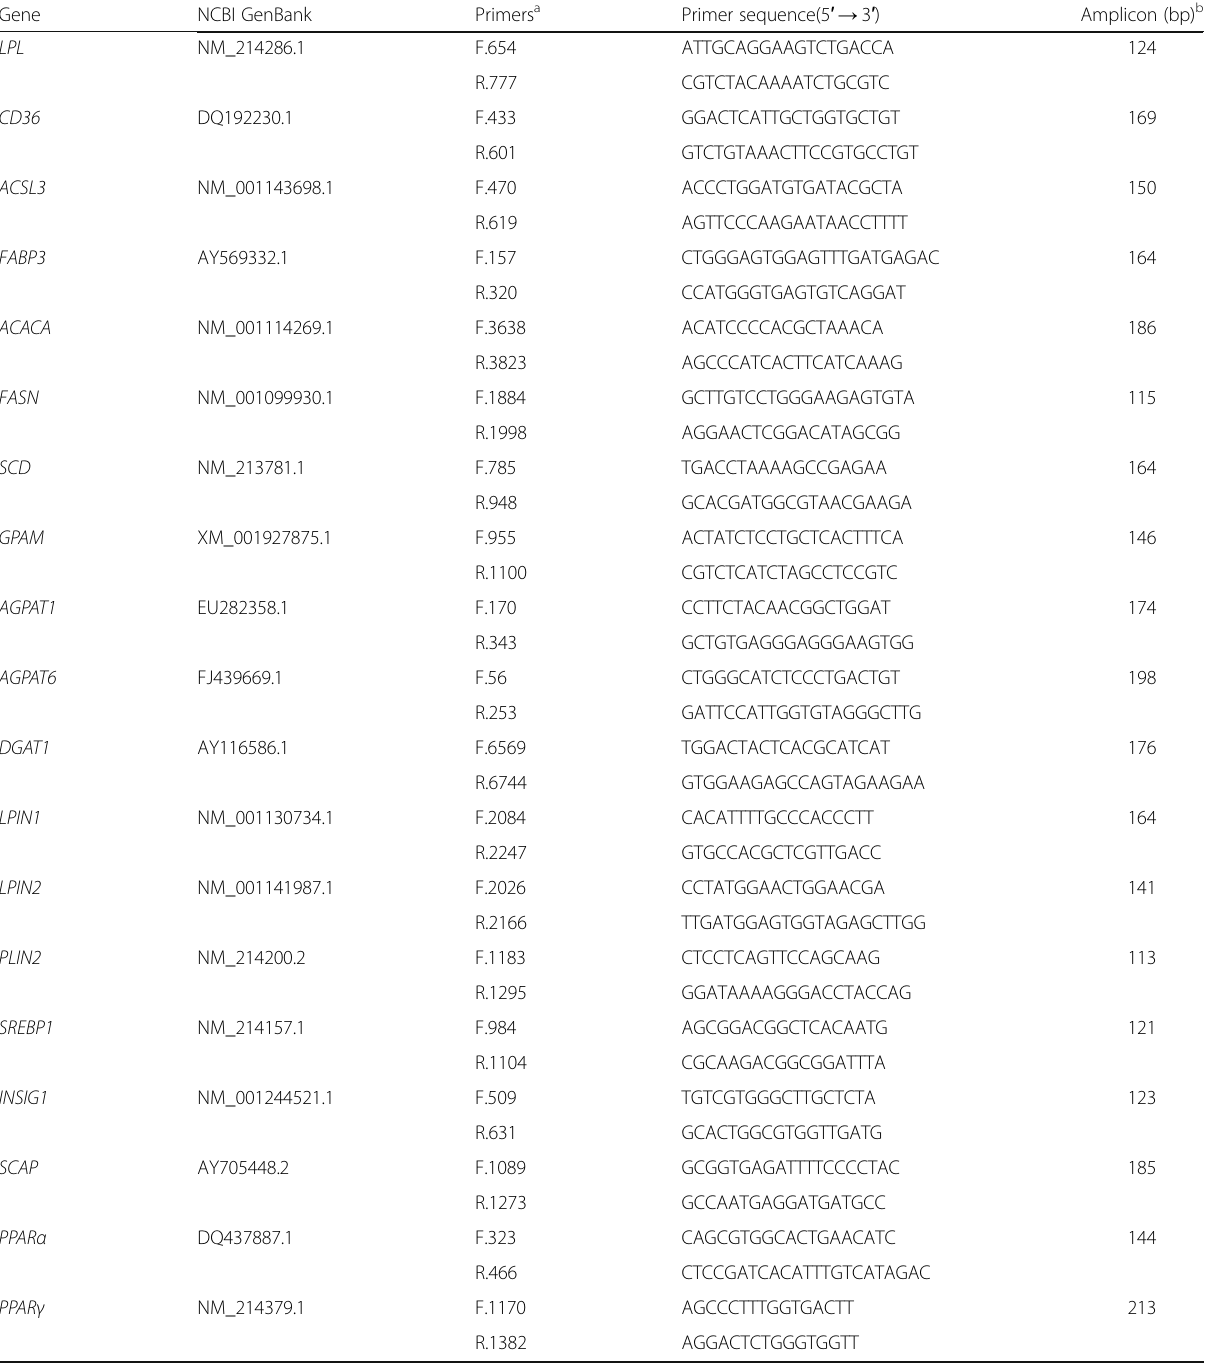
Table 1 Characteristics of primers used for real-time quantitative PCR analysis